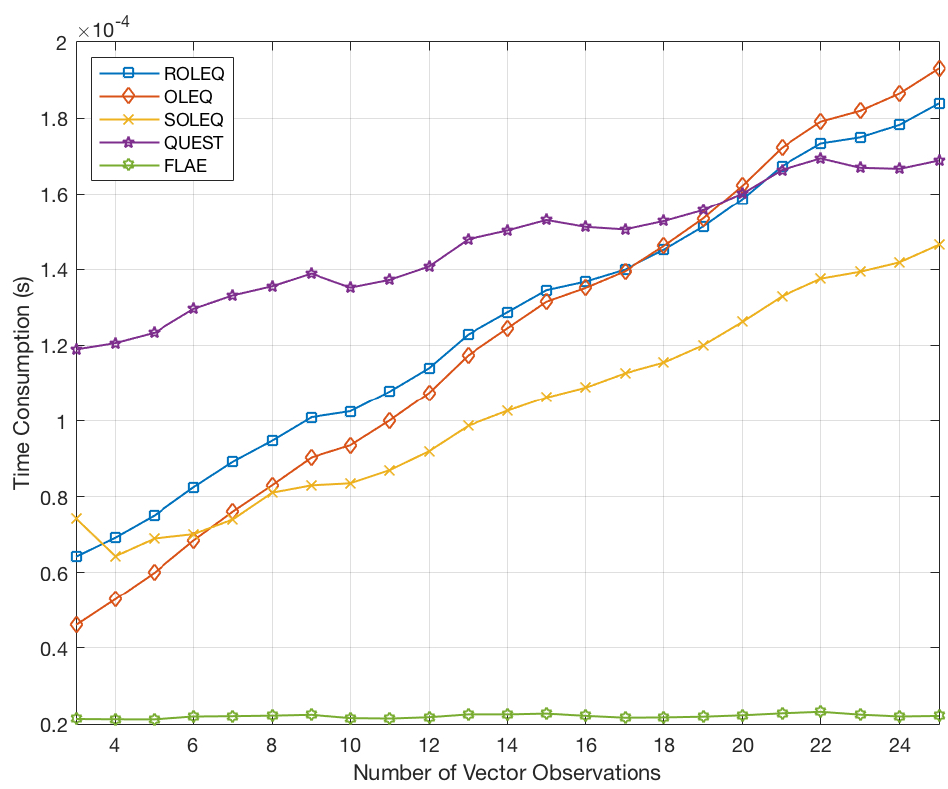
Figure 11. Time consumption of algorithms with respect to the number of vector